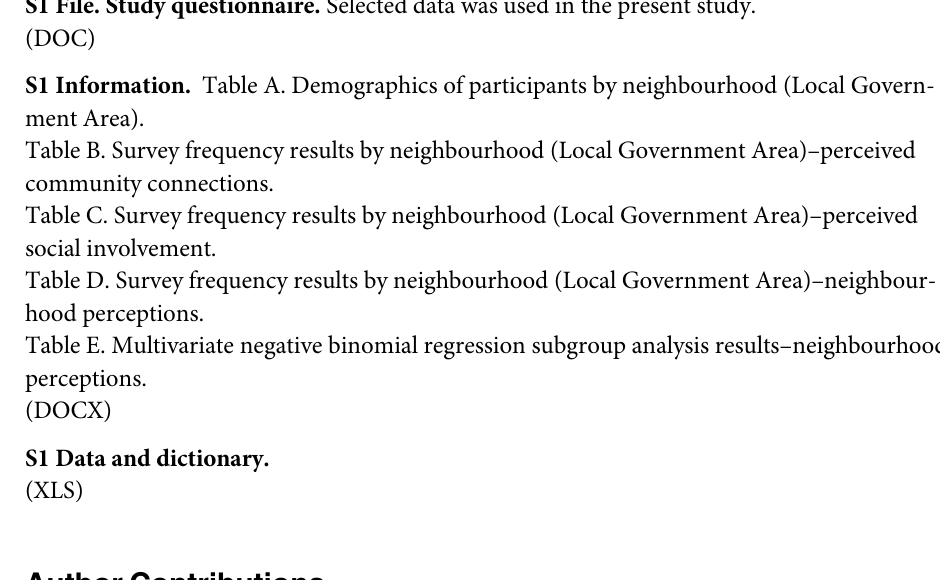
S1 Information. Table A. Demographics of participants by neighbourhood (Local Govern- ment Area). Table B. Survey frequency results by neighbourhood (Local Government Area)–perceived community connections. Table C. Survey frequency results by neighbourhood (Local Government Area)–perceived social involvement. Table D. Survey frequency results by neighbourhood (Local Government Area)–neighbour- hood perceptions. Table E. Multivariate negative binomial regression subgroup analysis results–neighbourhood